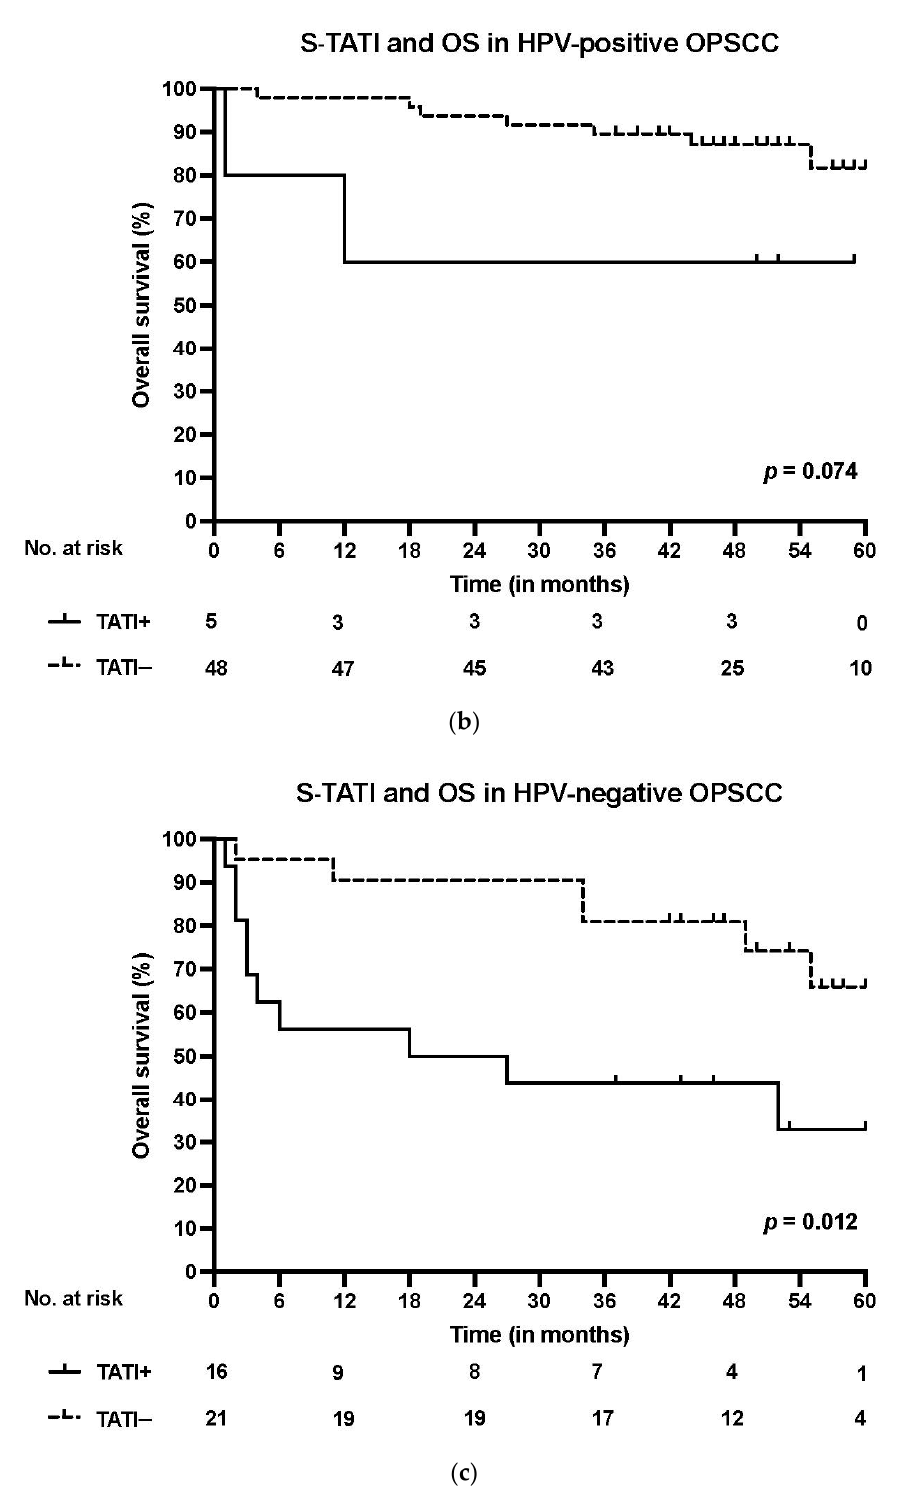
Figure 1. ( a ) Overall survival (OS) according to positive (>17 μ g/L) and negative (<17 μ g/L) S-TATI in the whole patient cohort. ( b ) Overall survival (OS) according to positive and negative S-TATI in HPV-positive OPSCC patients. ( c ) Overall survival (OS) according to positive and negative S-TATI in HPV-negative OPSCC patients.